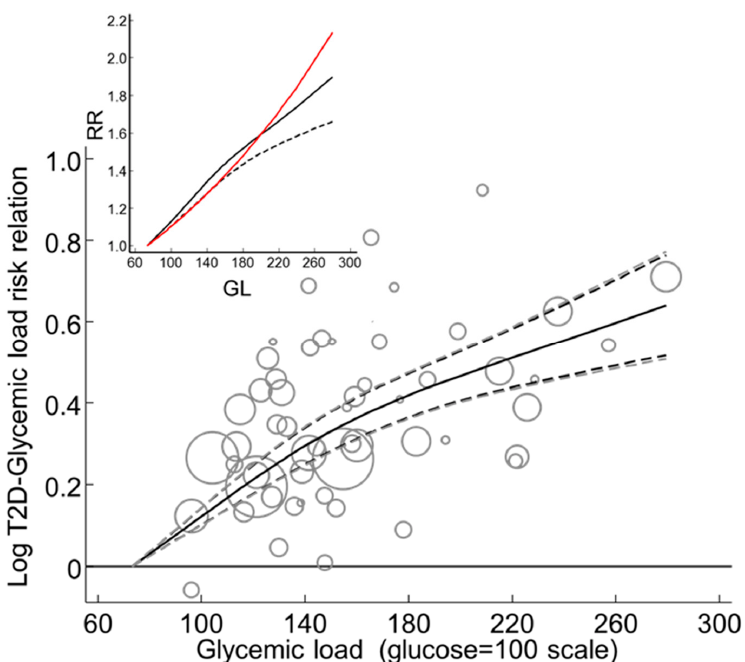
Figure 10. Global dose response meta-analysis of the T2D–glycemic load risk relation. The larger plot shows the mean increment in log risk relation and 95% CI values. Curves are the mean cubic-spline log risk relation (black, continuous) and the 95% CI values based on random e ff ects analysis. The inner (black dashed) shows the conventional CI values based on ( τ 2 + σ 2 ) whereas the outer (grey dashed) were based on an additional, forecasting term, σ f 2 , thus ( τ 2 + σ 2 + σ f 2 ), so that the 95% CIs were wider. Insert: Shows the RR (black, continuous line), the lower 95% confidence limit accounting for the three sources of error (black dashed line), and the corresponding log-linear prediction (red). The risk relation (RR) was per 80 g/d GL in a 2000 kcal (8400 kJ) diet.